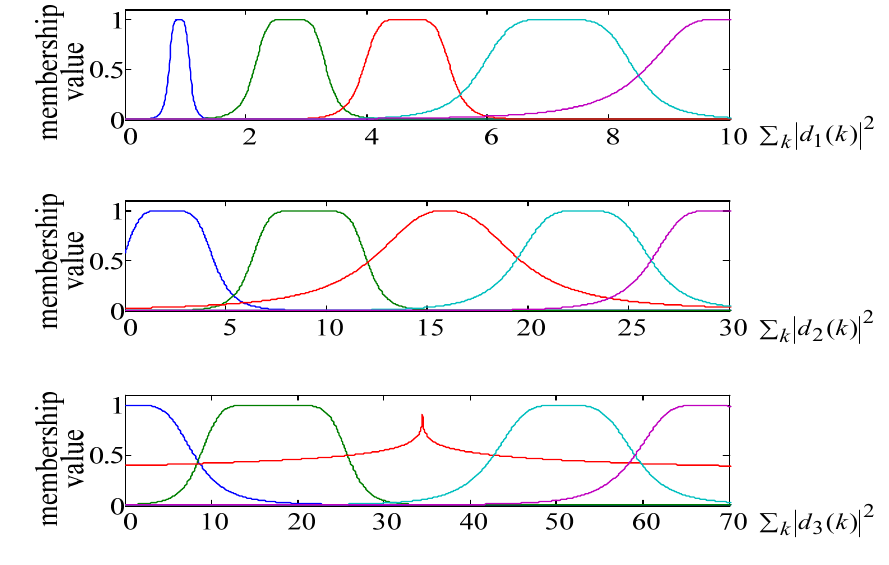
Figure 6. 15 membership functions (A1–A5, B1–B5, and C1–C5) of ANFIS used to identify faults in Zone 1.